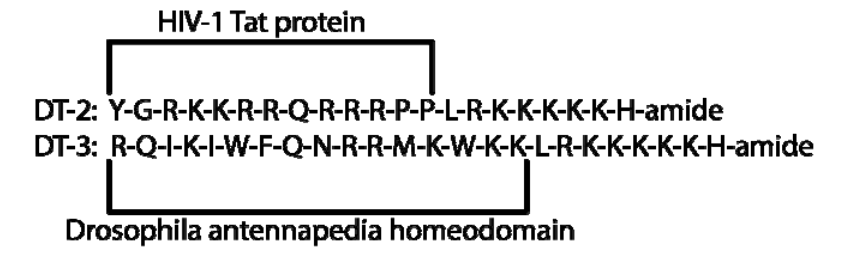
Figure 5. Amino acid sequence (one letter code) and composition of DT-2 and DT-3.